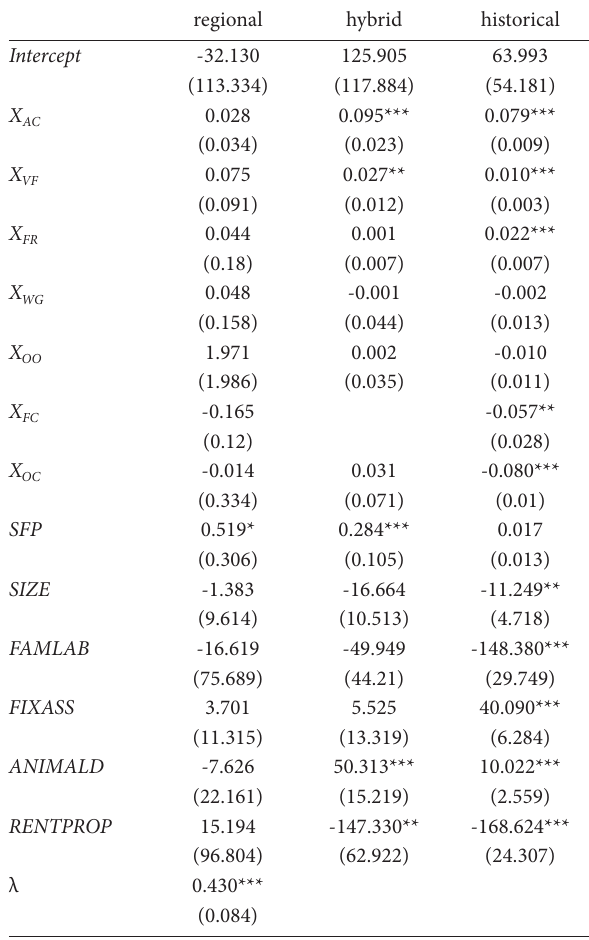
Table 4. Estimation results by implementation regime, EU